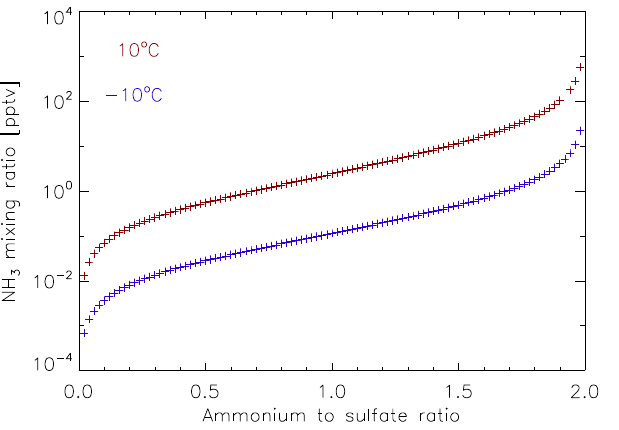
Figure 8. The aqueous phase concentration of NH + ameter water droplet, exposed to a 22pptv NH 3 gas phase, similar to the conditions of experiment